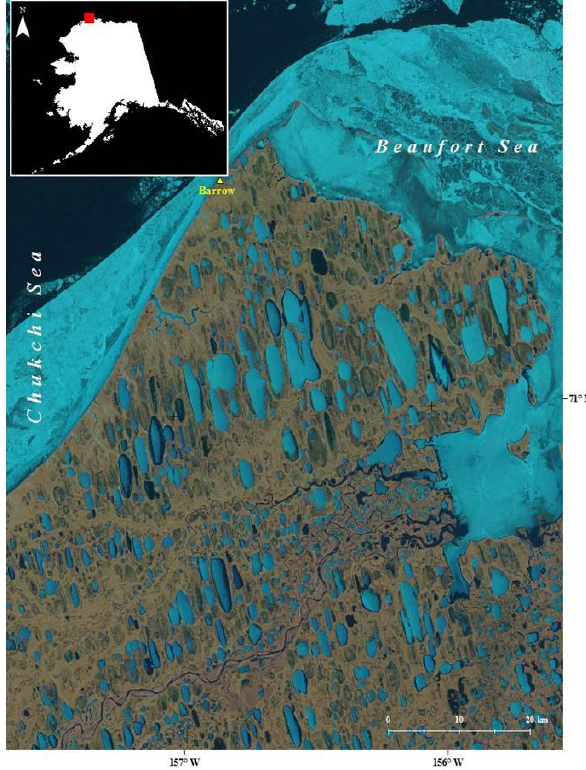
Figure 1. Sub-region of the Alaskan Arctic Coastal Plain, near Barrow (71°17’ N, 156 °46’ W). The satellite view of Barrow was provided by NASA, Landsat program 2011, Landsat TM L1T scene (ID: LT50790102011170GLC00). Publisher: USGS. Acquisition date – 9 June 2011.